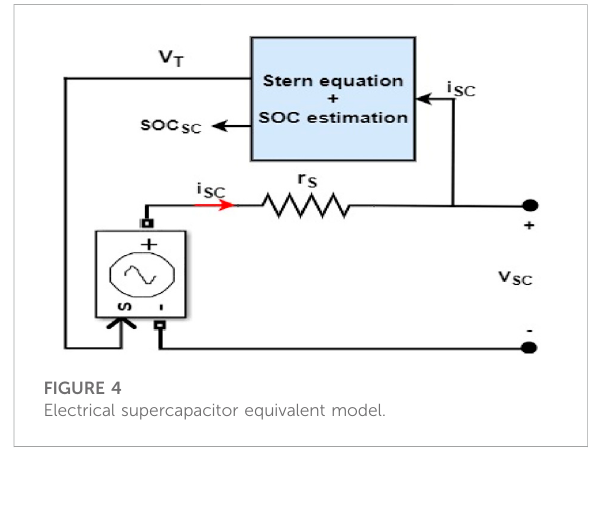
TABLE 2 HEV and environment